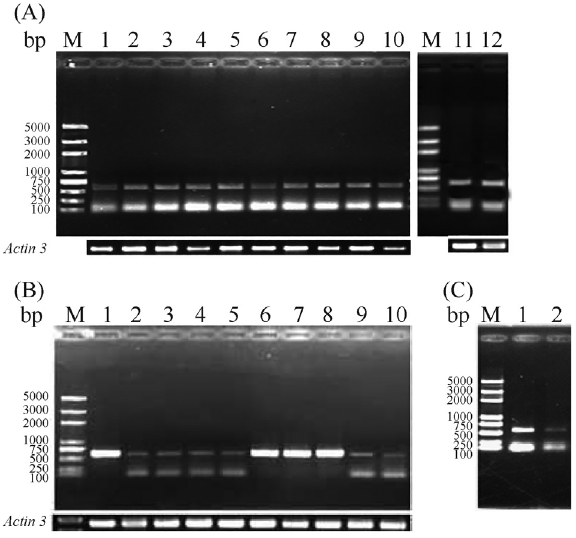
Figure1 -PCRscreeningforthepresenceof Wolbachia insilkworms.(A) PCR screening for wsp gene in the samples of domesticated silkworms. Lane M represents DL2000 plus DNA marker. Lanes 1-10 represent do- mesticated silkworm samples from the following strains: lane 1, 871 ; lane 2, 932 ; lane 3, 7532 ; lane 4, Xianghui ; lane 5, Yue ; lane 6, Hang7 ; lane 7, Shi7 ; lane 8, Feng9 ; lane 9, Furong ; lane 10, Yan7 . Lanes 11 and 12 repre- sent female and male samples from the strain Dazao , respectively. (B) PCR screening for the wsp gene in samples of wild silkworms. Lane M represents DL2000 plus DNA marker. Lanes 1-10 represent wild silk- worm samples from the following areas: lane 1, Dali; 2, Nanchong; 3, Peng’an; 4, Pingdu; 5, Qingmuguang; 6, Haining; 7, Xichang; 8, Huzhou; 9, Zhenjiang; 10, Rongchang. (C) PCR screening for the ftsZ gene in sam- ples of silkworm. Lane M represents DL2000 plus DNA marker. Lane 1, Dali; 2, Dazao. All PCR fragments were cloned and sequenced. Se- quencing results showed that the bigger bands in lanes 1-12 are fragments of the wsp (A, B) or ftsZ genes (C), whereas the second, smaller band in lanes was non-specifical PCR